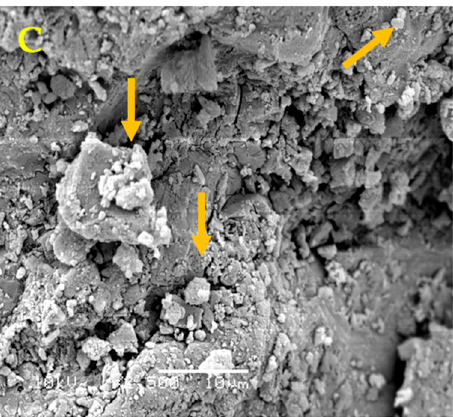
Figure 2. Scanning electron microscopic images of the ( A ) chitosan scaffold surface (1000 × ), and ( B ) the chitosan scaffold surface with simvastatin (1000 × ). ( C ) chitosan scaffold internal morphology (2500 × ). Arrows indicate simvastatin presence.